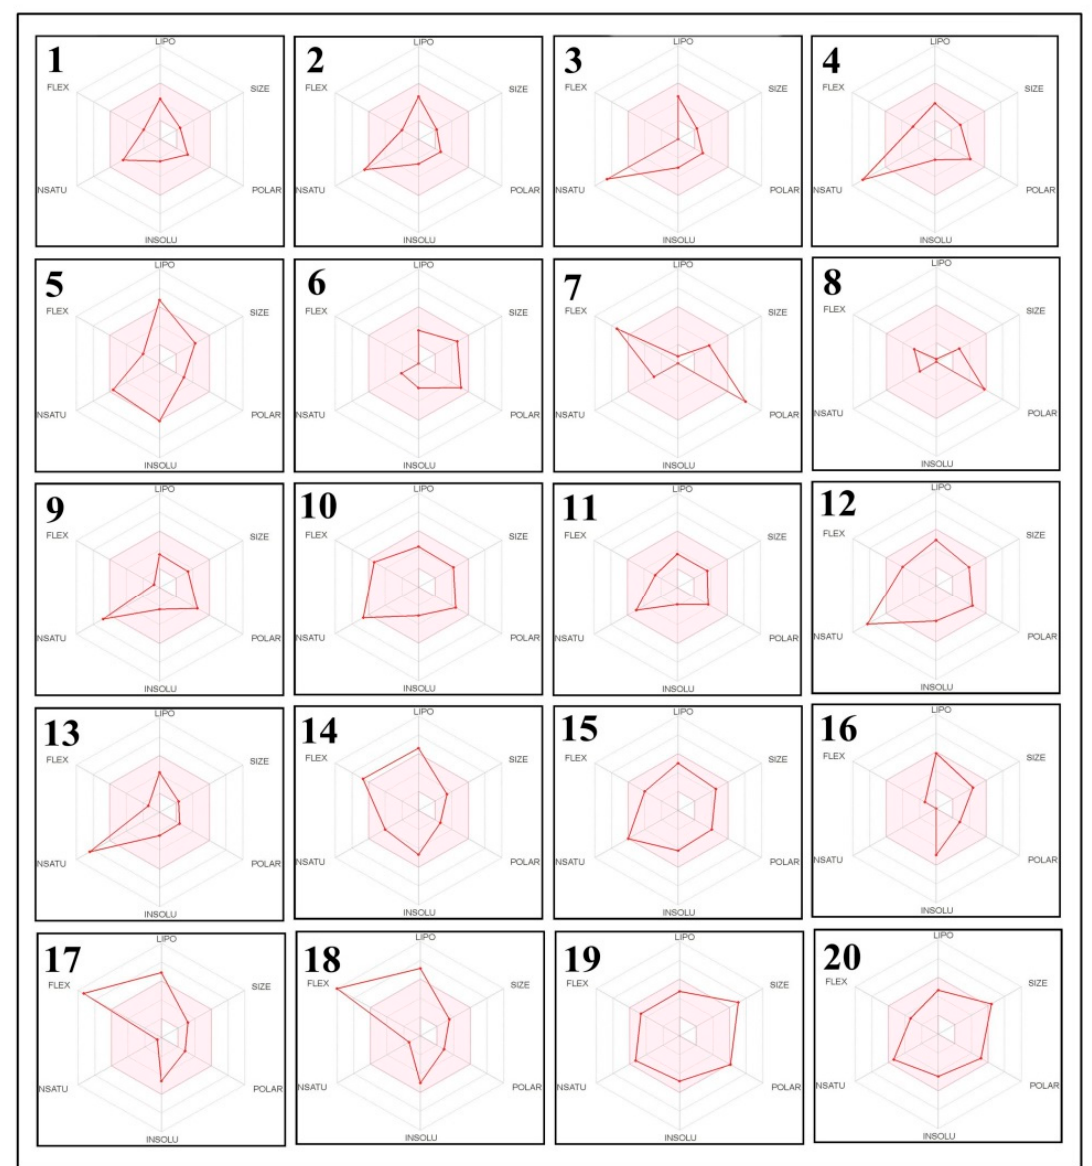
Figure 6. Bioavailability radar of the phytochemical compounds of E. sativa based on the physico- chemical indices ideal for oral bioavailability. The pink area represents the optimal range for each property (lipophilicity: XLOGP3 between − 0.7 and +5.0; size: MW between 150 and 500 g/mol; po- larity: TPSA between 20 and 130 Å2; solubility: log S not higher than 6; saturation: fraction of car- bons in the sp3 hybridization not less than 0.25; and flexibility: no more than 9 rotatable bonds). (1) (+/ − )-3-[(2-methyl-3-furyl)thio]-2-butanone; (2) methyl N